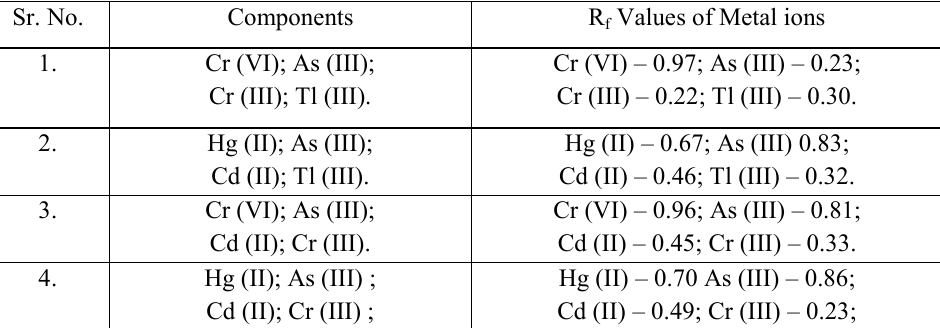
Table 5. Quaternary